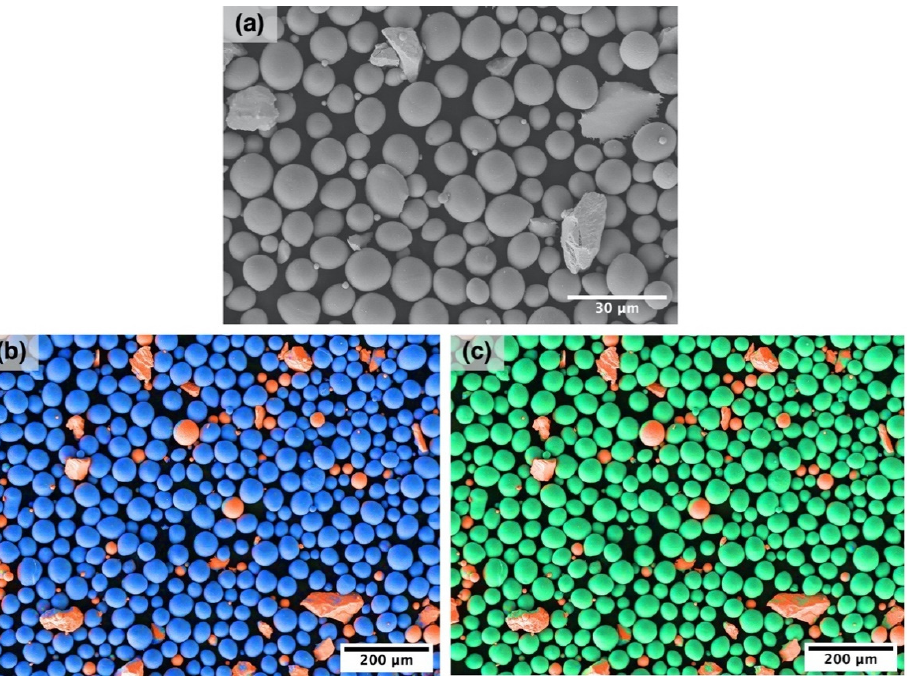
Figure 1. ( a ) SEM-image of the NiTi-Nb powder blend and chemical distribution of the elements in the blend: ( b ) blue—Ti and red—Nb and ( c ) green—Ni and red—Nb. Table 1. SLM process parameters used to fabricate the